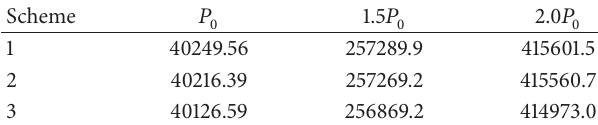
Table 4: Unbalanced forces of dam heel (10 4 N).